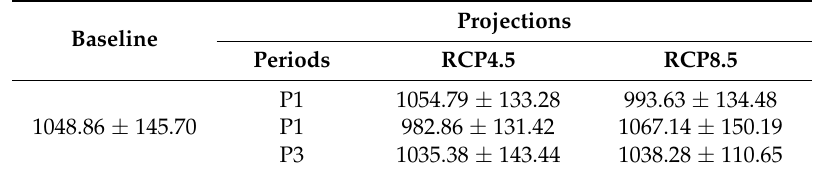
Table 2. Mean and Standard deviation of rainfall over baseline and projected periods.